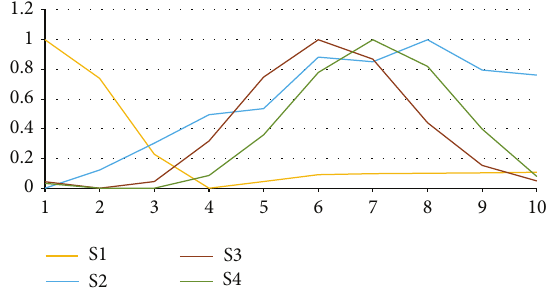
Figure 7: Patterns representing sick persons.